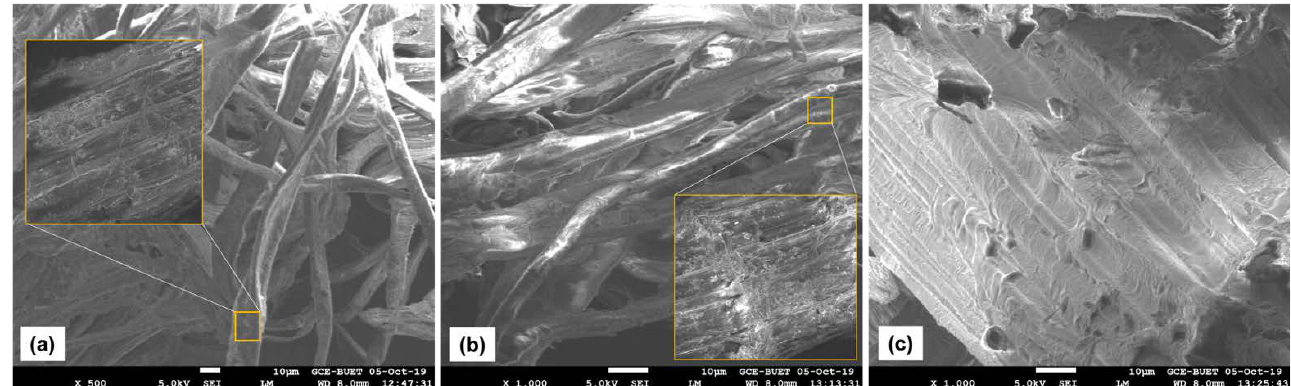
Figure 4. SEM micrograph of ( a ) raw banana fibers, ( b ) alkali treated banana fibers, and ( c ) water repellent-treated banana fiber nonwovens.